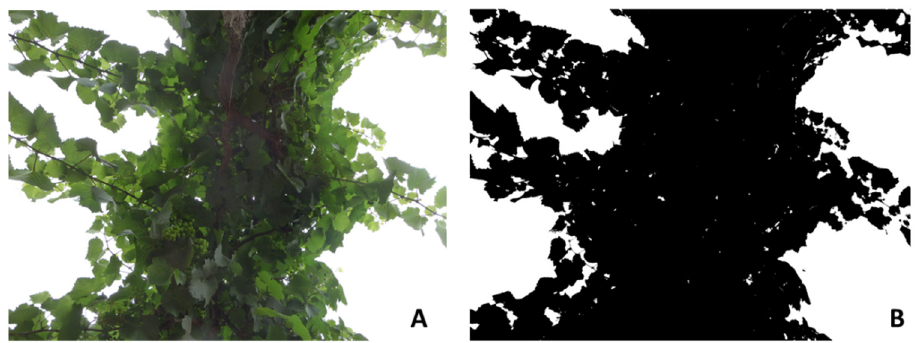
Figure 2. Example of ( A ) an upward-looking digital image from a grapevine canopy and ( B ) binari- zation for gap analysis to obtain canopy architecture parameters.